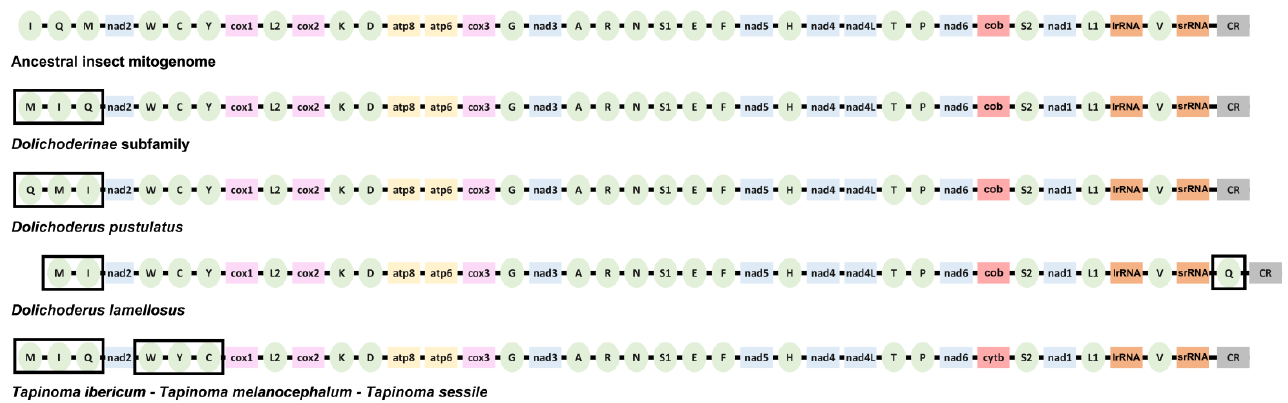
Figure 4. Mitochondrial gene arrangements in Dolichoderinae species.